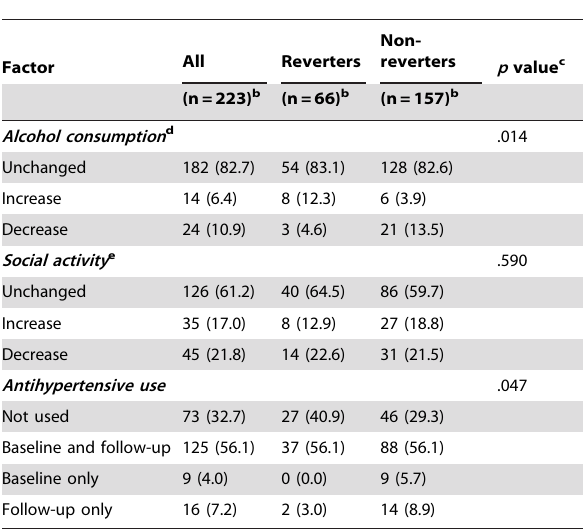
Table 5. Change in potentially modifiable categorically- measured characteristics and antihypertensive use from baseline to follow-up a